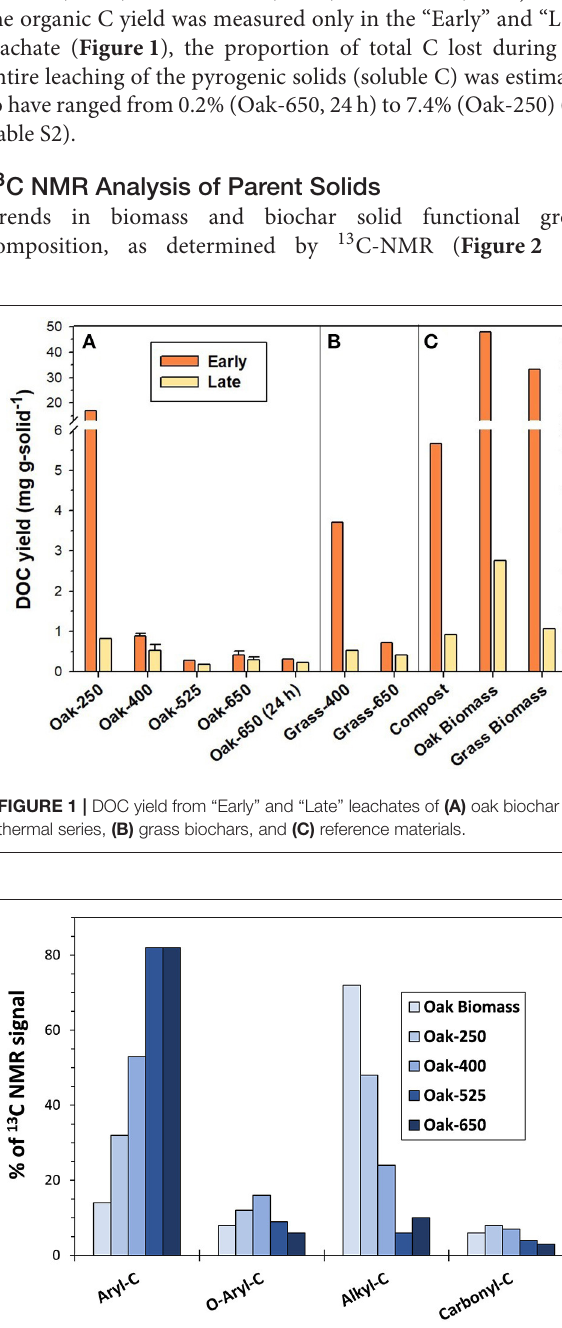
FIGURE 2 | Solid State 13 C-NMR functional group abundances for non-pyrolyzed oak biomass and oak biochar (parent solid) thermal series. See the text for chemical group